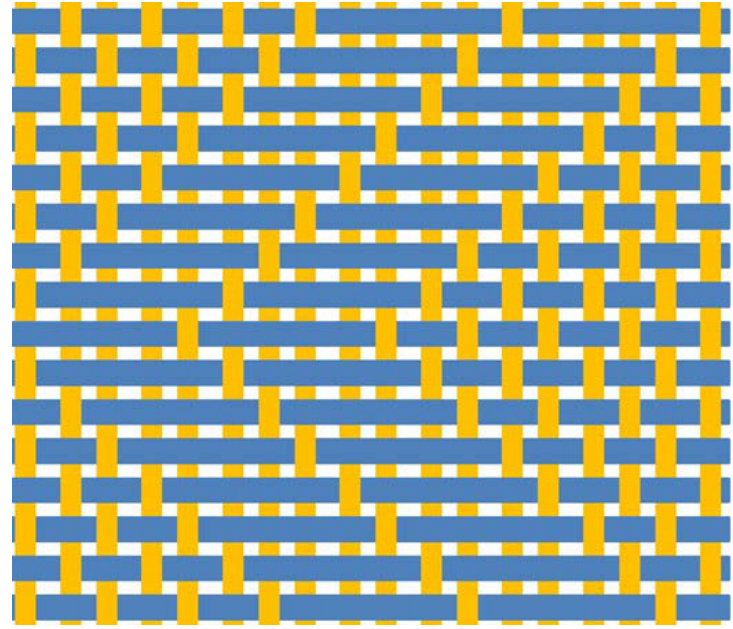
Figure 1. Foldable strips in a zig-zag way along the warp.